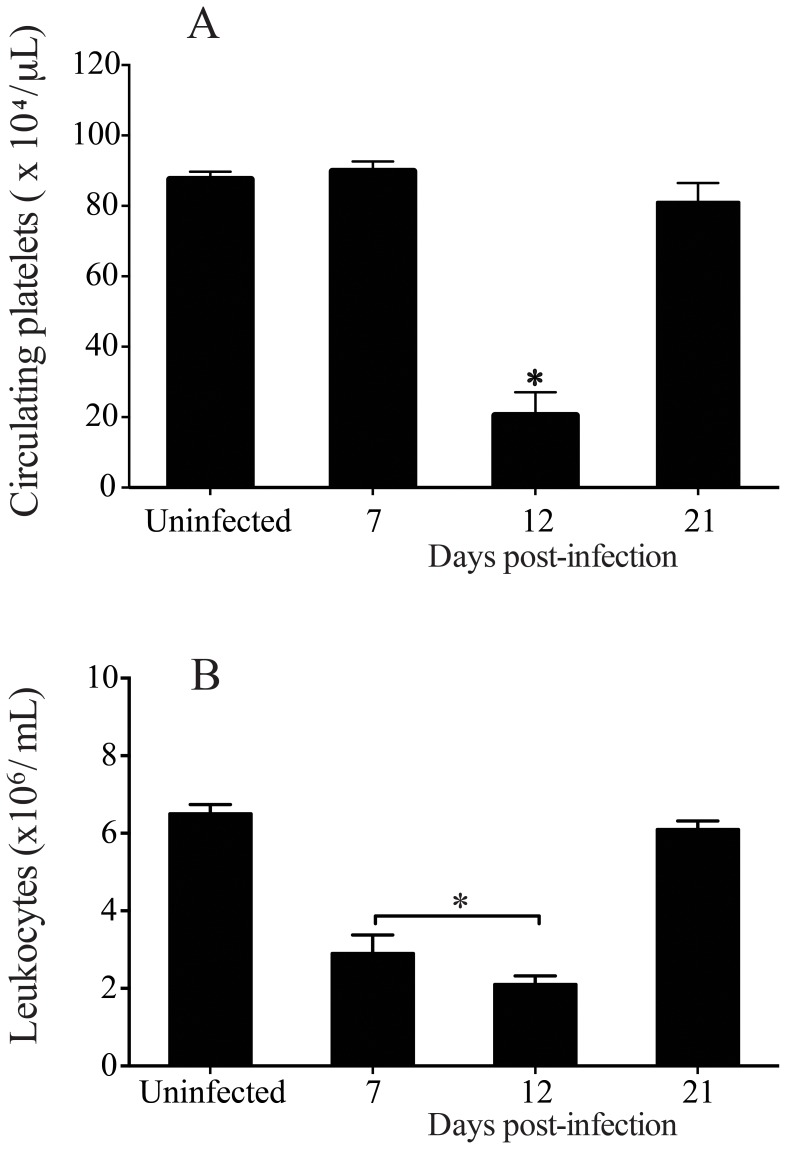

T.
cruzi infection induces thrombocytopenia and leukopenia transients in the early of infection.C5BL/6 mice were infected with 5×103 trypomastigotes (Y strain) via i.p. injection, monitored for the development of thrombocytopenia and leukopenia, and sacrificed at different time points post-T. cruzi infection. A: platelets and B: leukocytes were counts from peripheral blood from uninfected and infected mice. Values represent the mean ± standard error and are representative of three independent experiments, using 4–15 mice per group. Results were analyzed by analysis of variance (ANOVA) followed by Bonferroni multiple comparisons test. Asterisks indicates significant differences (p<0.05) when compared with control group (uninfected).